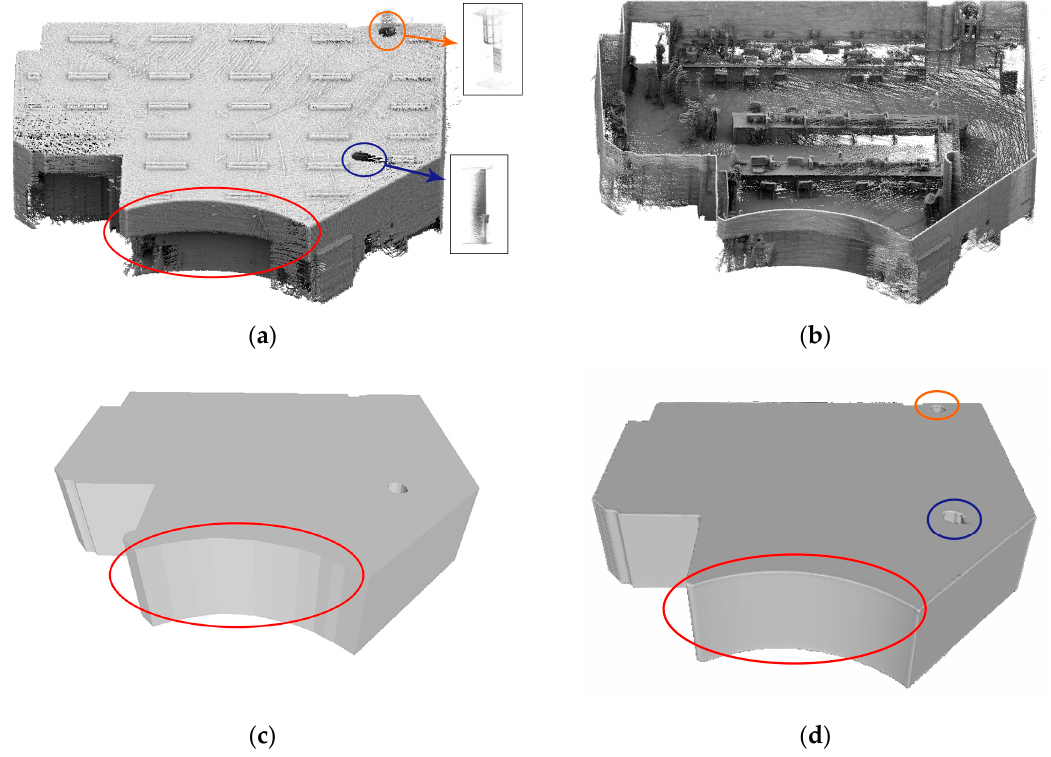
Figure 9. Comparison of the model reconstructed from the handheld laser scanner (HLS) dataset with curved wall structure: ( a ) raw point cloud dataset (the curved wall structure points are in the red circle, and the pillar points and the specific object points are in the blue circle and orange circle respectively), ( b ) raw point cloud dataset without ceiling, ( c ) model generated from Shi’s approach (the curved wall structure is in the red circle), ( d ) model generated from our approach (the curved wall structure is in the red circle, and the pillar and the specific object are in the blue circle and orange circle respectively).